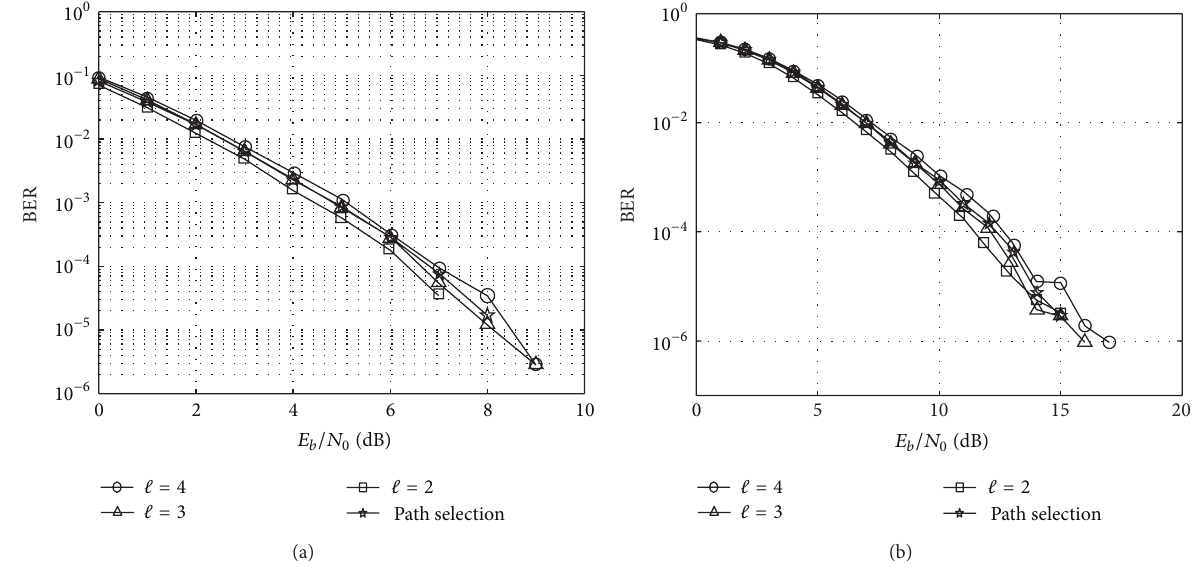
Figure 5: BER performance of OFDM system over the six-path fading channel with 13nsec delay spread for (a) 16-QAM modulation and (b) 64-QAM